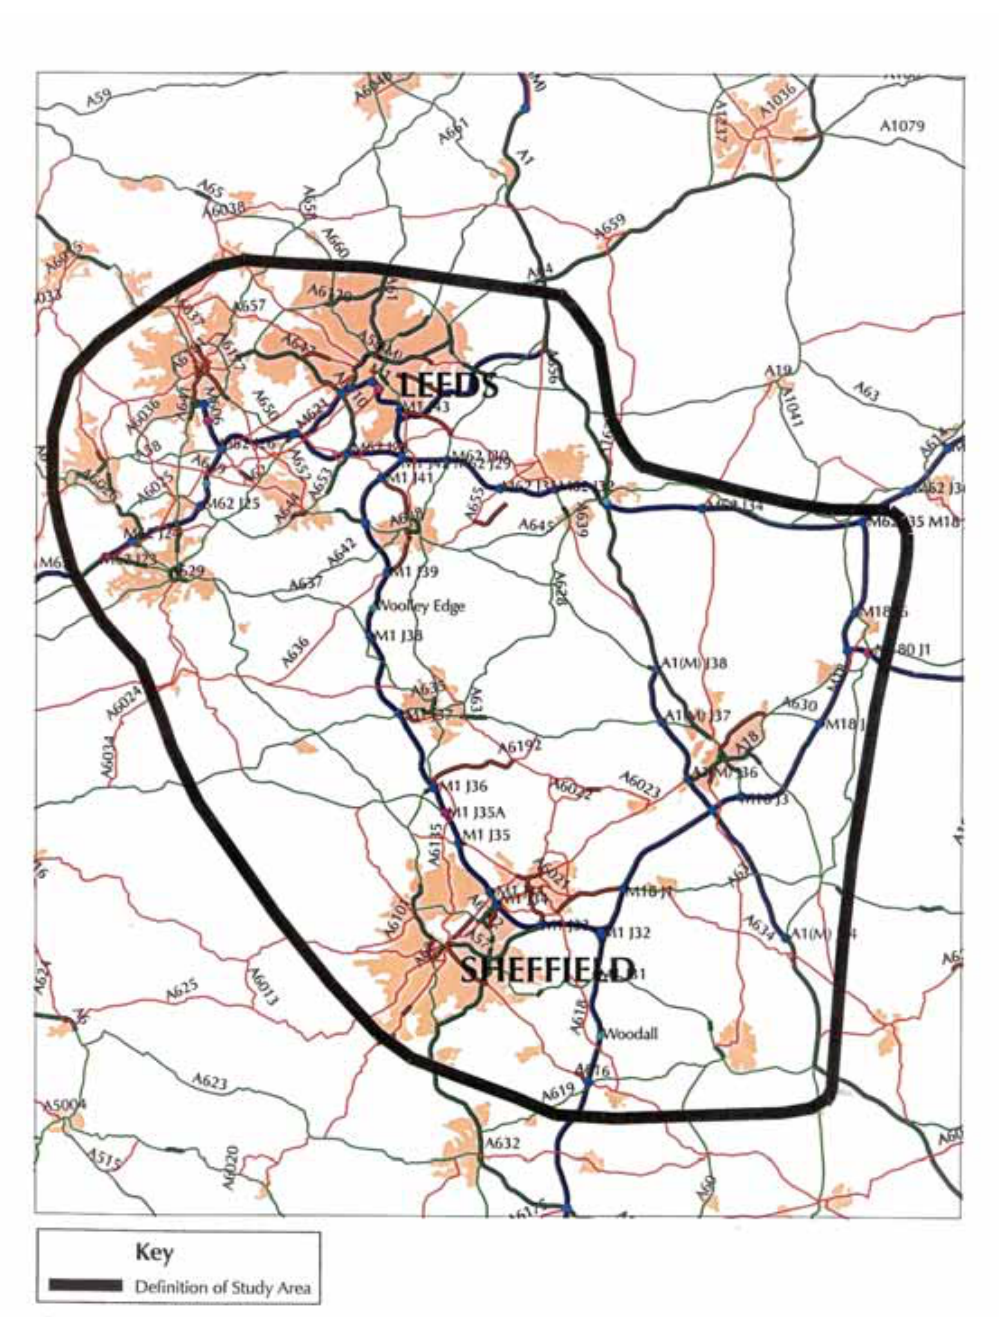
Figure 2. SWYMMS Study